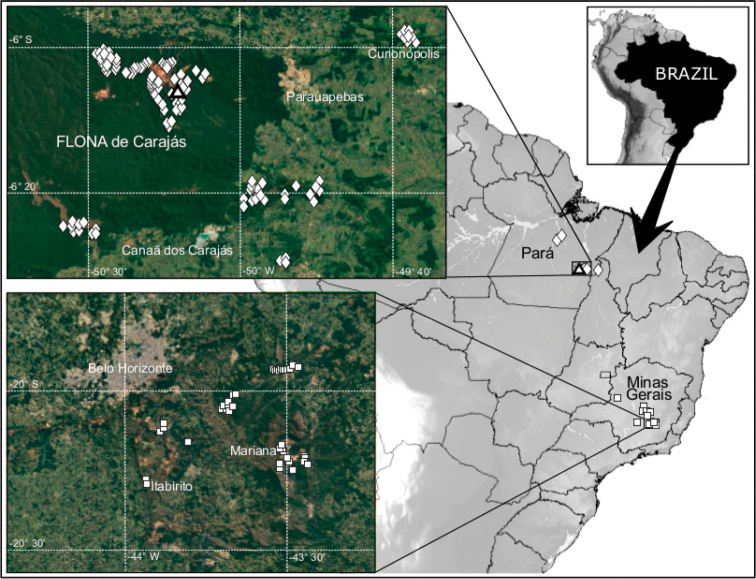
Distribution maps of Plato
ferriferus sp. n. (diamond), P.
striatus sp. n. (triangle) and P.
novalima sp. n. (square) in states of Pará and Minas Gerais, Brazil.